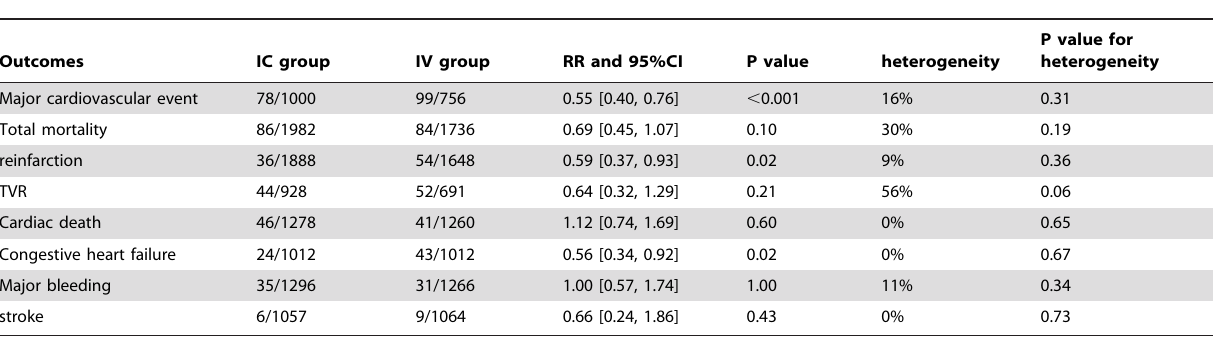
Table 2. Summary of the relative rates with its 95%CI of all outcomes